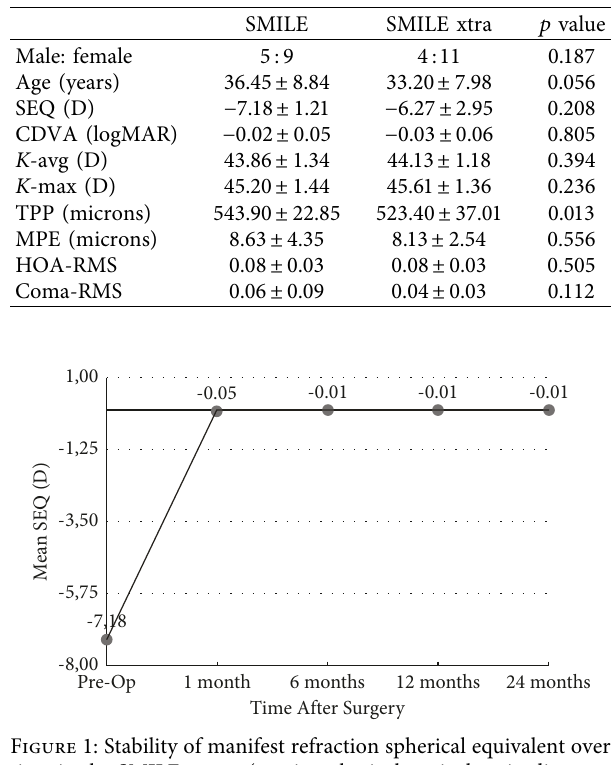
Table 1: SEQ: spherical equivalent; CDVA: corrected distance visual acuity; K -avg: Keratometry average; K -max: Keratometry maximum; TPP: thinnest point pachymetry; maximum posterior elevation; HOA-RMS: high-order aberration root mean square; Coma-RMS: coma root mean square.